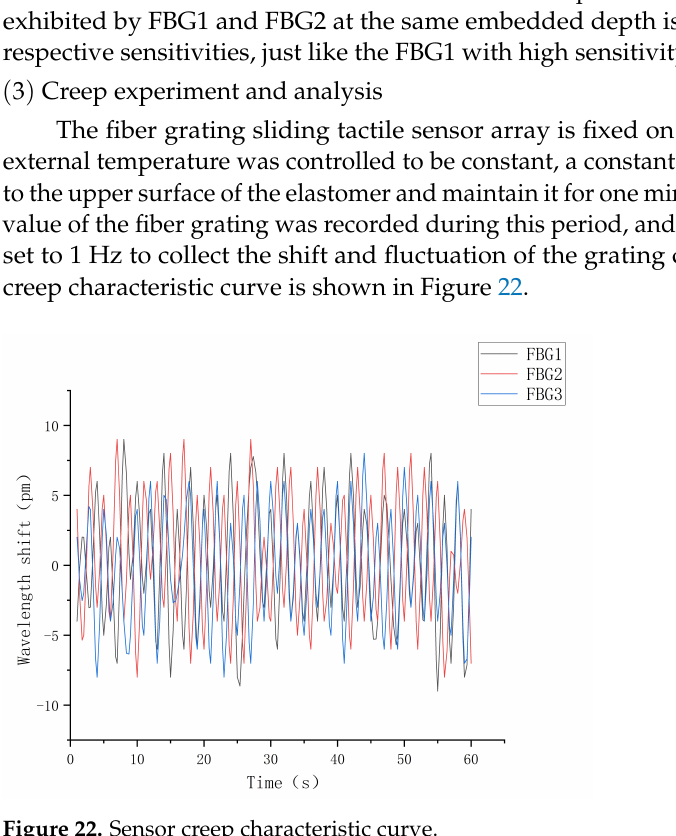
Figure 22. Sensor creep characteristic